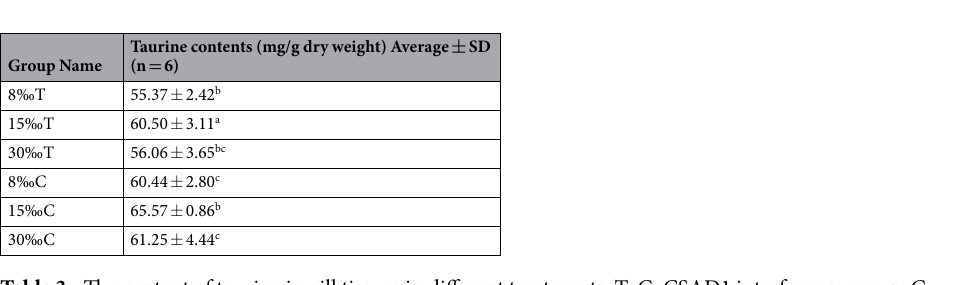
Table 3. The content of taurine in gill tissues in different treatments. T: CgCSAD1 interference group. C: 150 mM NaCl injected group. Different superscript letters indicate significant difference among means (p < 0.05). Method: one-way